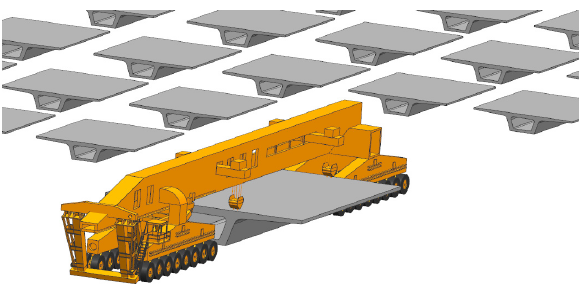
Figure 18. Storage site of prefabricated beams.